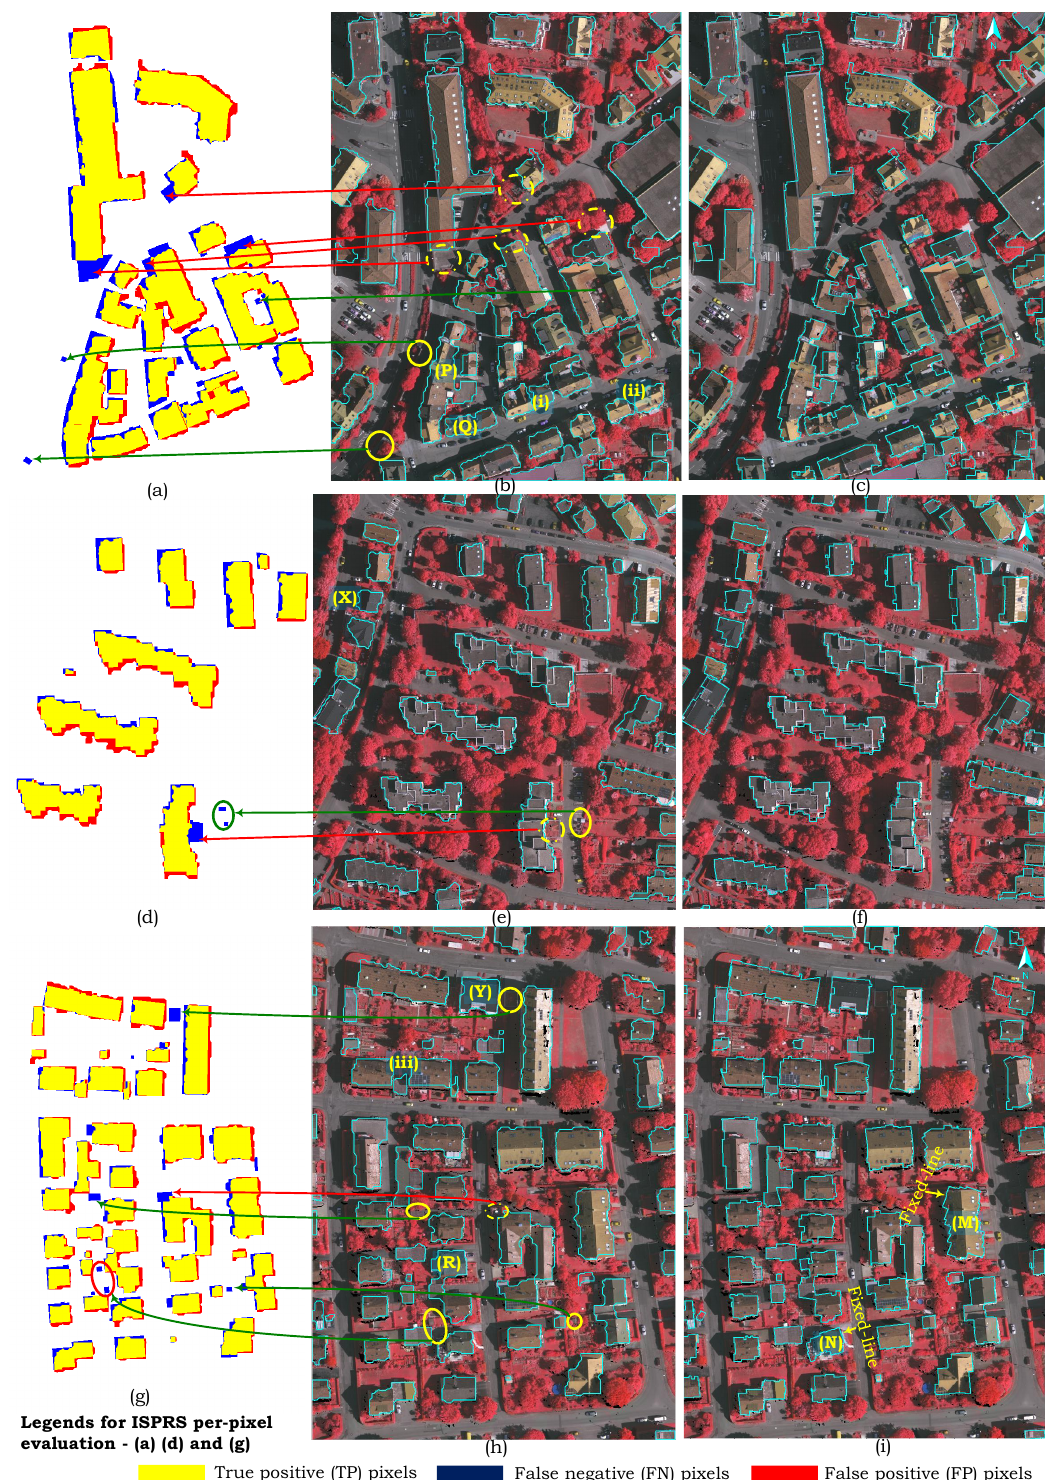
Figure 13. Building detection on the ISPRS German data set: ( a – c ) Area 1, ( d – f ) Area 2, and ( g – i ) Area 3. Column1: pixel-based evaluation, Column2: boundary before regularisation, and Column 3: regularised